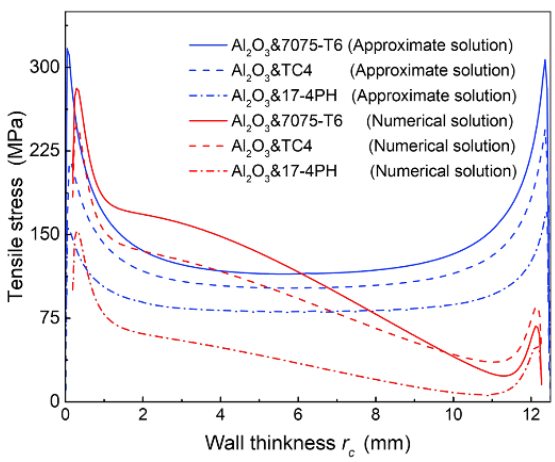
Figure 9. Linearized distribution of tensile stress on the contact surface along the wall thickness (three groups of Al 2 O 3 ceramic pressure housings).